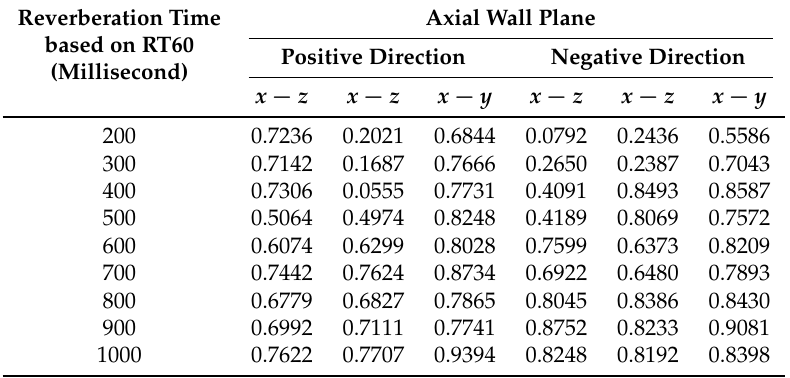
Table 3. Wall absorption coefficients at various reverberation time in Scenario 4